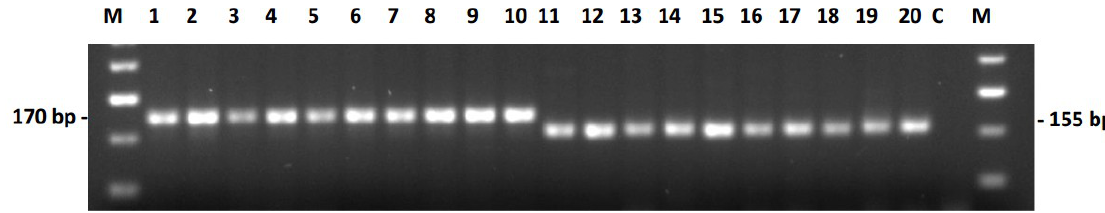
Figure 5. PAMSA marker derived from BAC end sequence of 67N04. 1-10 represent restorer lines, 11-20 maintainer lines; 1 = RHA 273, 2 = RHA 294, 3 = RHA 298, 4 = RHA 311, 5 = RHA 325, 6 = RHA 354, 7 = RHA 363, 8 = RHA 376, 9 = RHA 396, 10 = RHA 858, 11 = HA 228, 12 = HA 249, 13 = HA 285, 14 = HA 288, 15 = HA 307, 16 = HA 319, 17 = HA 320, 18 = HA 425, 19 = HA 442, 20 = HA 446, C = negative control, M = 50 bp marker New England BioLabs ® .